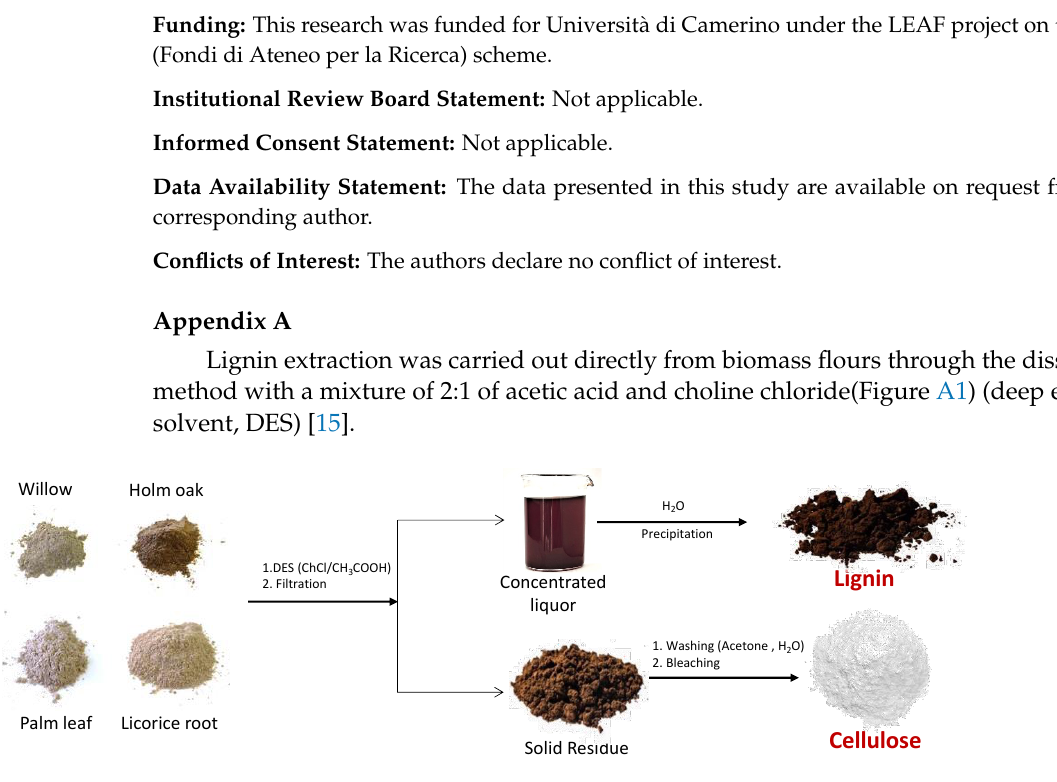
Figure A1. Extraction procedure starting from biomasses.